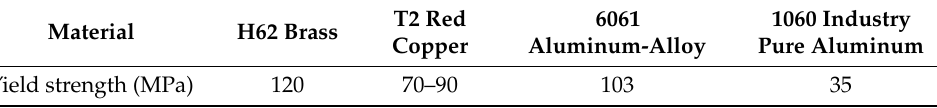
Table 1. The yield strength of the four selected metallic materials.